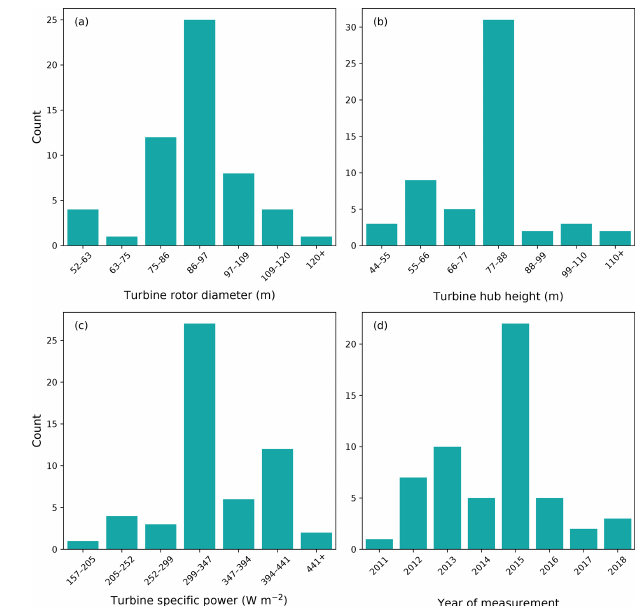
Figure 4. The 55 submissions included turbines with rotor diame- ters from 50 to 154 m (a) , hub heights from 44 to 143m (b) , and spe- cific power from 157 to 583Wm − 2 (c) . The tests were performed between 2011 and 2018 (d) . These histograms display results with- out any filtering (discussed in Appendix C).